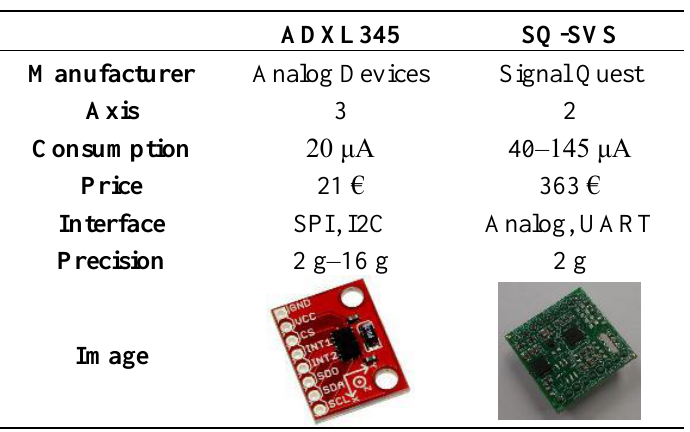
Table 2. Technical characteristics of evaluated